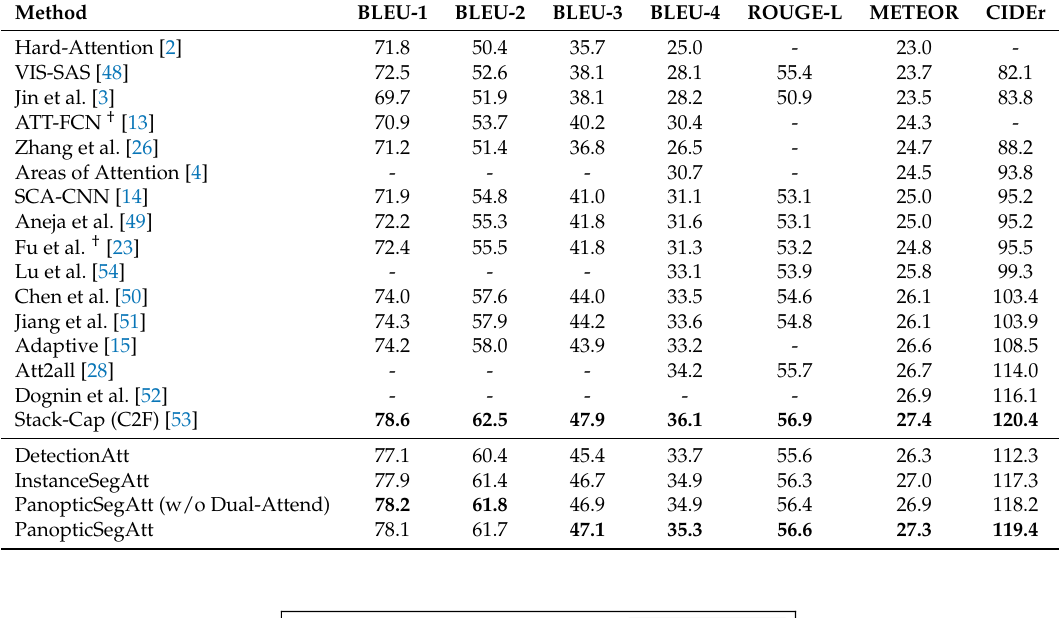
Table 1. The results obtained on the MSCOCO Karpathy test split [42]. † indicates ensemble models. Higher is better in all columns. Scores were multiplied by a factor of 100.